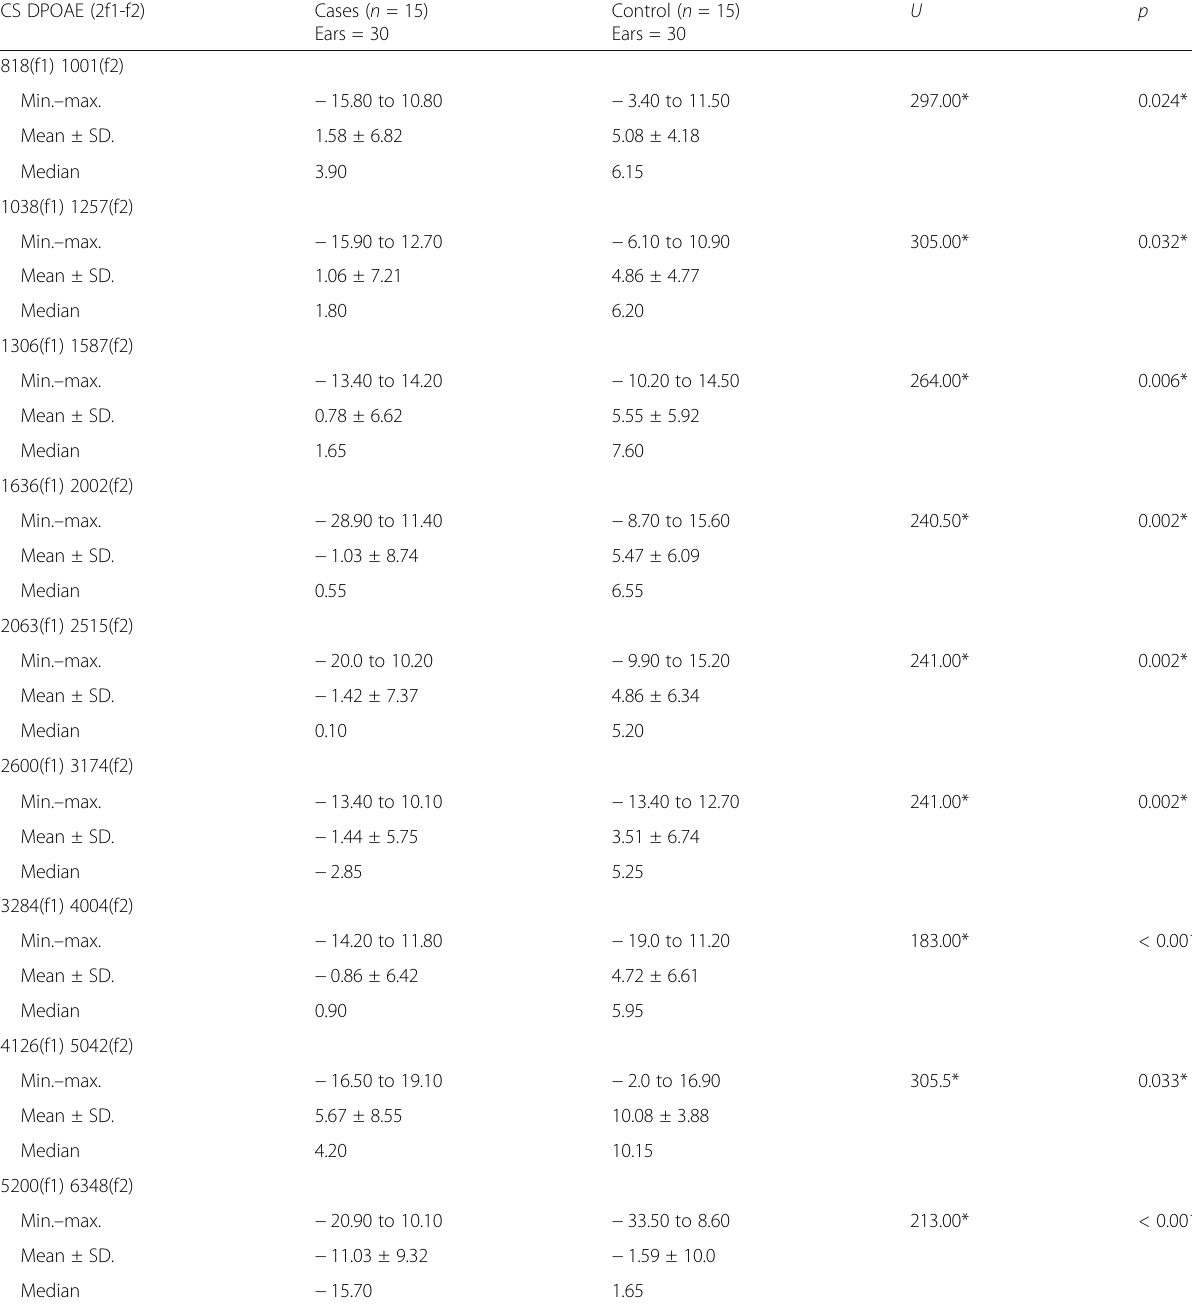
Table 2 Contralateral suppression (CS) of DPOAE amplitudes in dB SPL according to 2f1-f2 in tinnitus patients and control group CS DPOAE